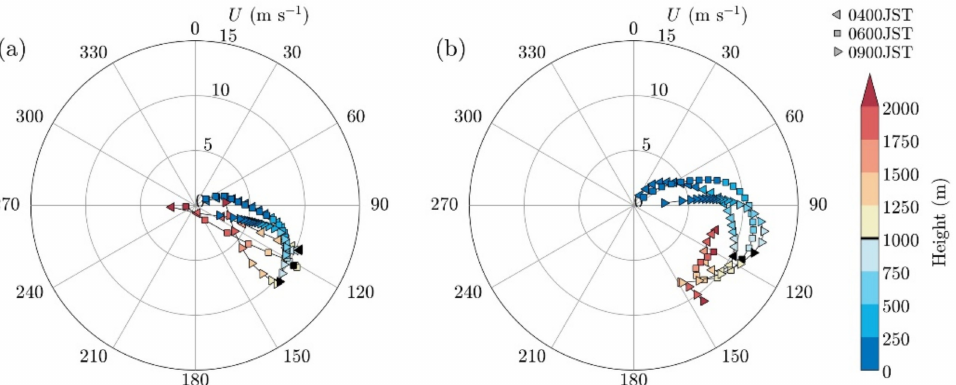
Figure 4. ERA5 reanalysis data (single point over the study area) showing horizontal wind speed and direction from the surface up to 2 km (shaded) at three different times: two hours before the study period (0400 JST; left–pointing triangle marker), start of the study period (0600 JST; square marker), and at the end of the study period (0900 JST; right–pointing triangle marker). Data are shown for: ( a ) the June case and ( b ) the October